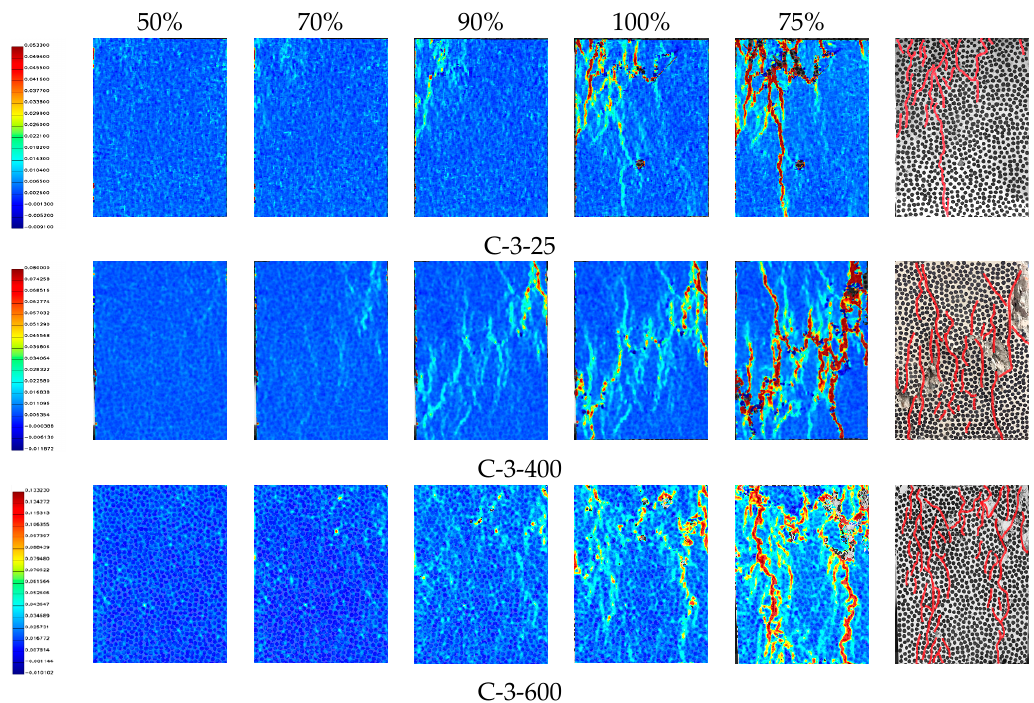
Figure 9. Distribution of principal strain.